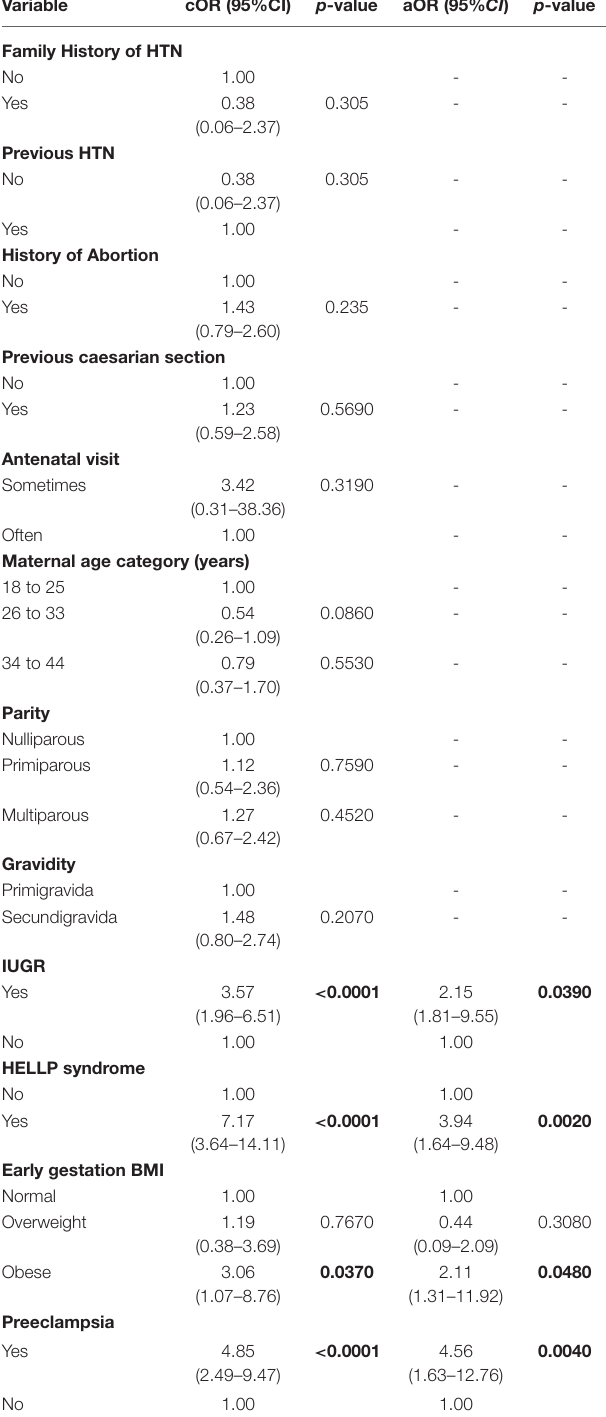
TABLE 4 | Multivariate Logistic regression of clinical and perinatal predictors of preterm birth among study participants.